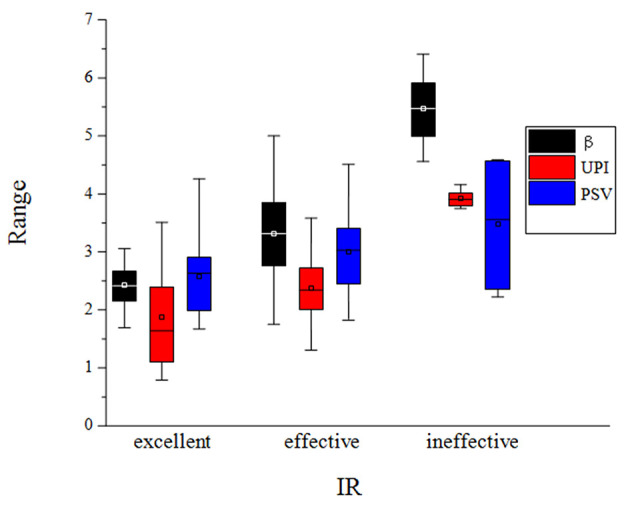
The box diagram of β, UPI and PSV in different treatment effect groups, in which the black box diagram represents the β value, the red box diagram represents the UPI value, and the blue box diagram represents the PSV value.